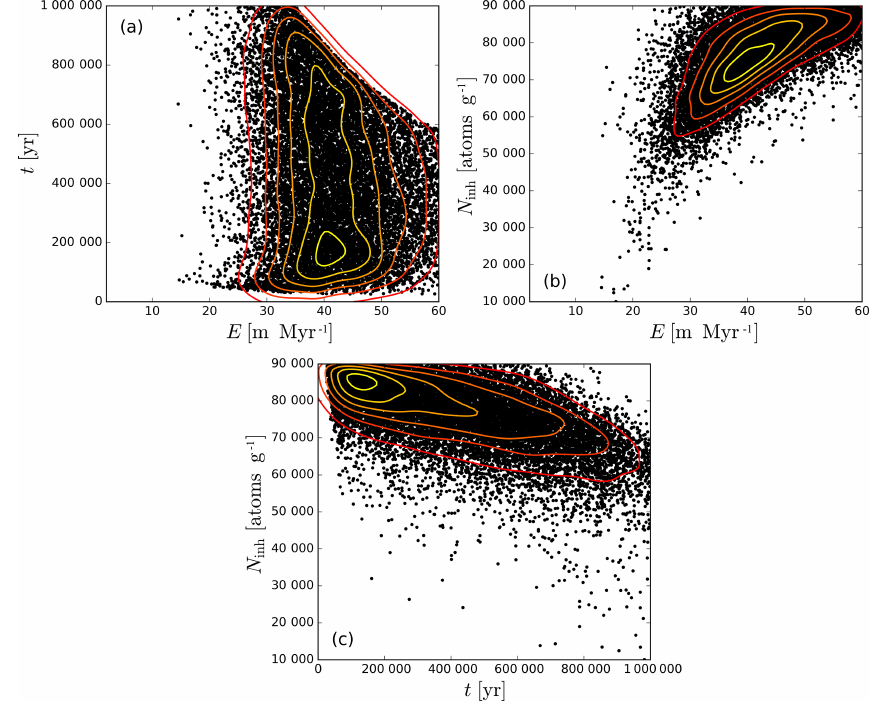
Figure 8. Selected scatter plots together with iso-density contour lines for the sampled posterior parameter distribution by our approach. Black dots are posterior parameter sets and the density increases with the line color ranging from red (lower density) to yellow (higher density).